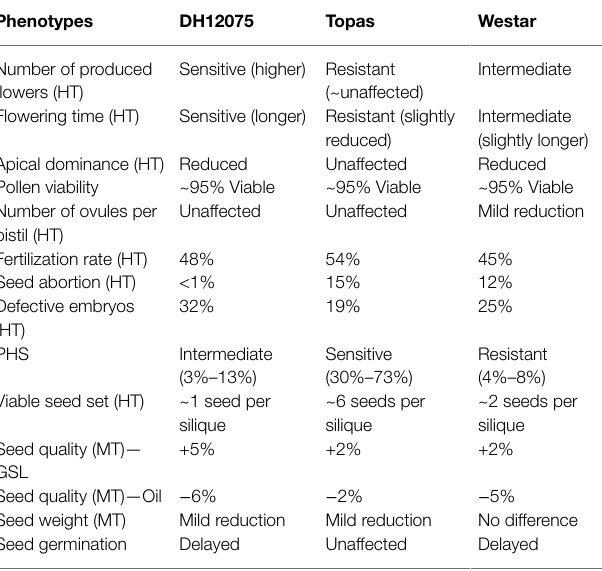
TABLE 4 | Comparison of the impact of warm ambient temperatures in the three studied